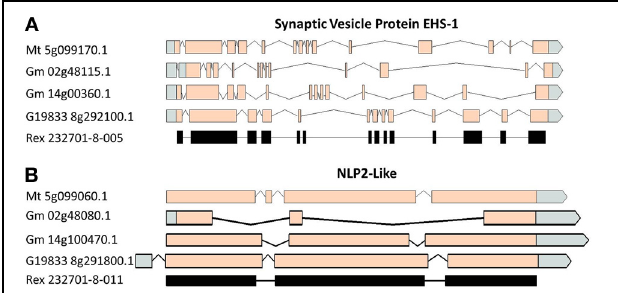
FIGURE 9 | Gene structure comparisons of genes surrounding the Niemann Pick gene locus in M. truncatula , G. max , and P. vulgaris . Two genes from upstream (A) and downstream (B) of the Niemann Pick like genes are compared for their exon/intron structure similarities. Homologies were very high, BLAST e = 0 . 0.